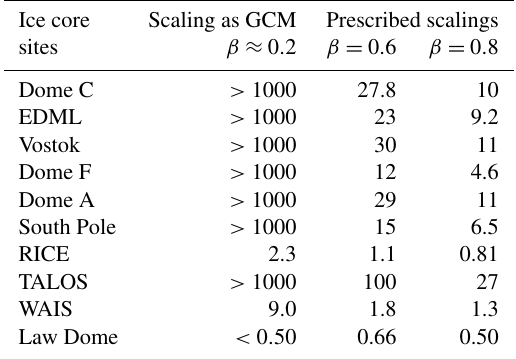
Table 3. Signal retrieval timescales τ a (SNR = 1 after block aver- aging) in years for the main Antarctic ice core sites including the impact of precipitation intermittency, diffusion, and measurement noise and for three assumed climate spectrum scaling